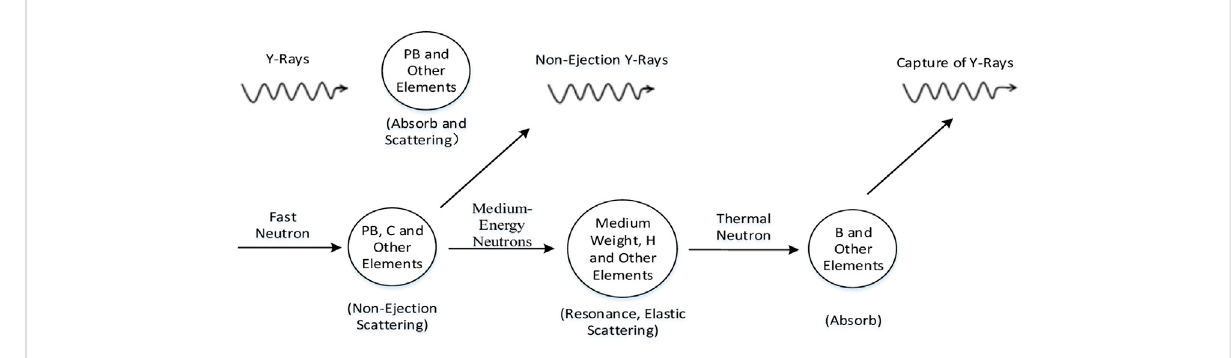
FIGURE 1 Schematic diagram of shielding principle for common shielding